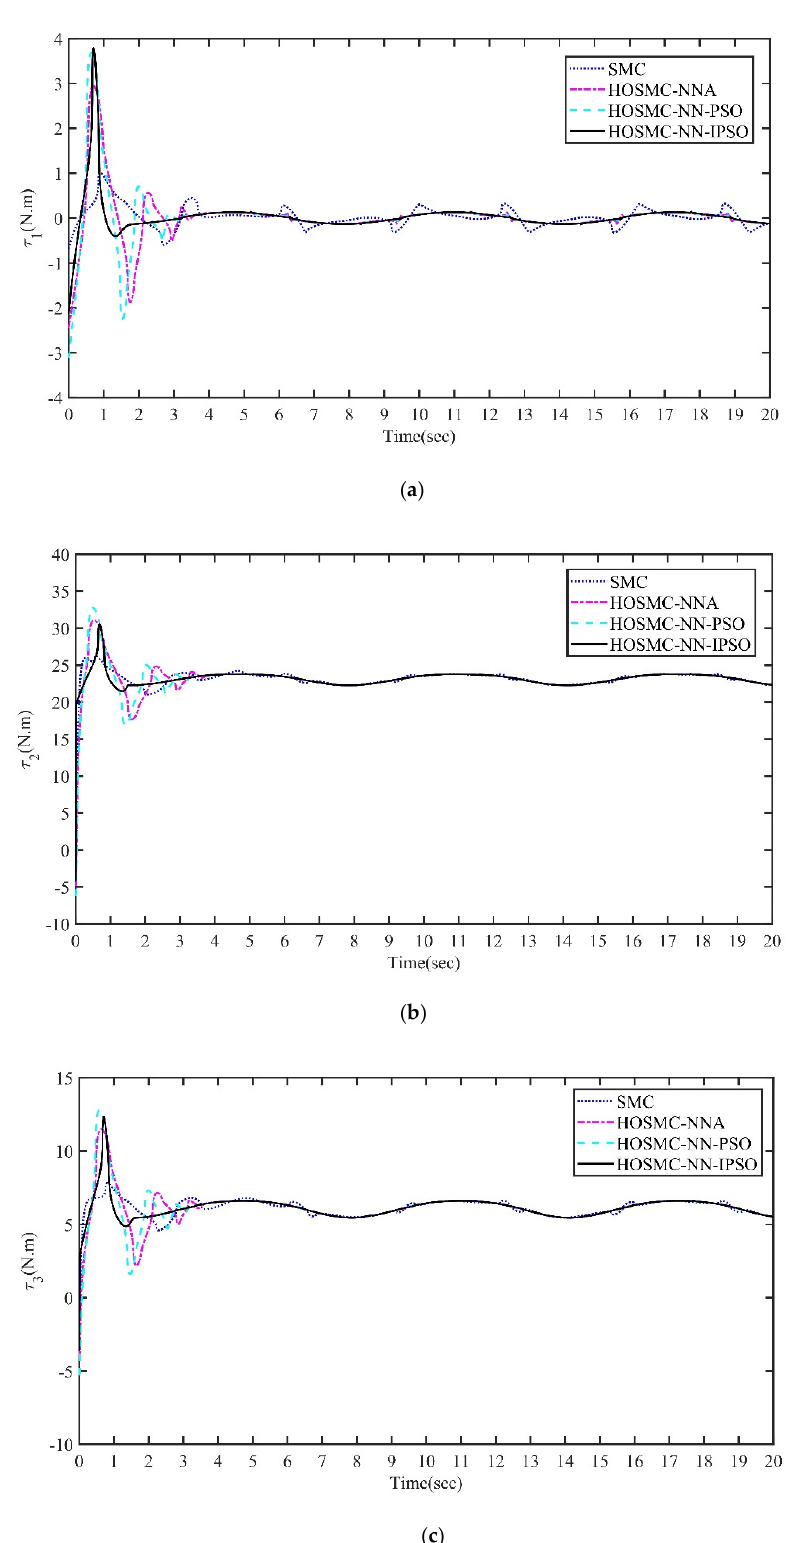
Figure 6. Angular velocity tracking of joints under SMC, HOSMC − NNA, HOSMC − NN − PSO and HOSMC − NN − IPSO controllers. ( a ) Angular velocity tracking of joint 1. ( b ) Angular velocity track- ing of joint 2. ( c ) Angular velocity tracking of joint 3.